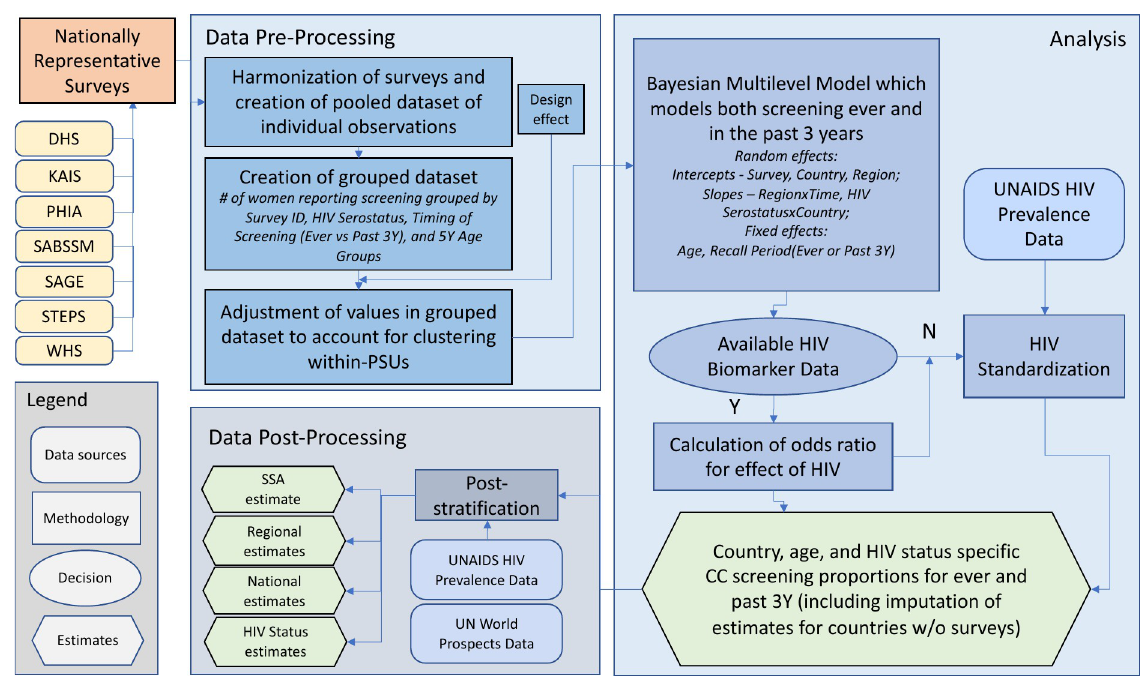
Fig 1. Conceptual framework outlining data inputs, data pre-processing, statistical analyses, and data post-processing to estimate lifetime and past 3-year cervical cancer screening time trends by age, country, and HIV serostatus. CC, cervical cancer; PSU, primary sampling units; SSA, sub-Saharan Africa; UNAIDS, The Joint United Nations Programme for HIV/AIDS; UN, United Nations. DHS, Demographic and Health Surveys ; PHIA, Population-Based HIV Impact Assessment ; SAGE, Study on Global AGEing and Adult Health ; STEPS, STEPwise Approach to NCD Risk Factor Surveillance ; WHS, World Health Surveys ; KAIS, Kenya AIDS Indicator Survey ; and the SABSSM, South Africa National HIV Prevalence , Incidence , Behavior and Communication Survey